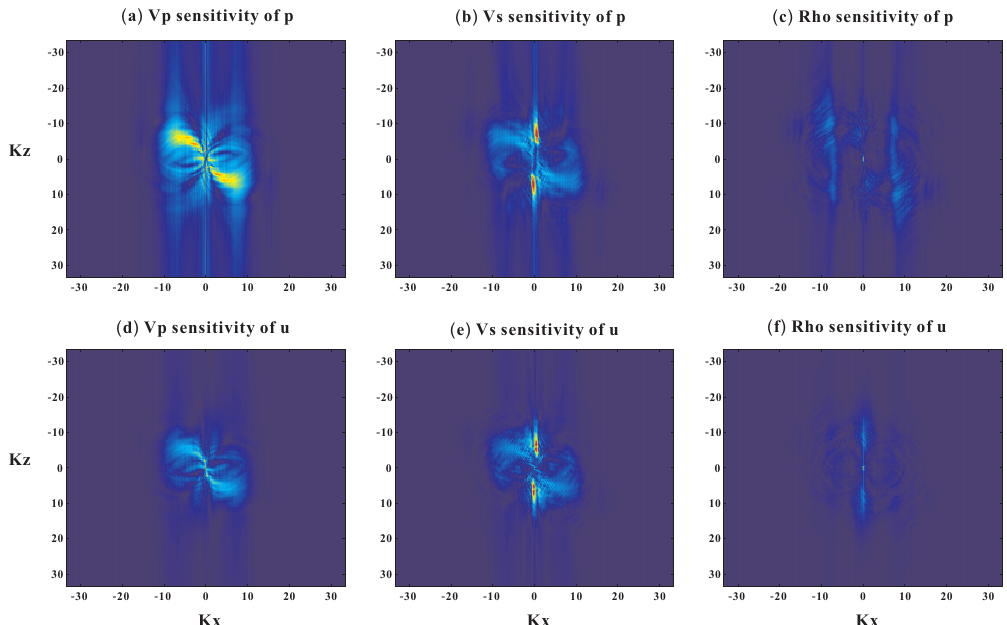
Figure 3. The 2D Wavenumber spectrum for the sensitivity kernels of pressure (top) and displacement (bottom) components with respect to ( a , d ) Vp , ( b , e ) Vs , and ( c , f ) ρ